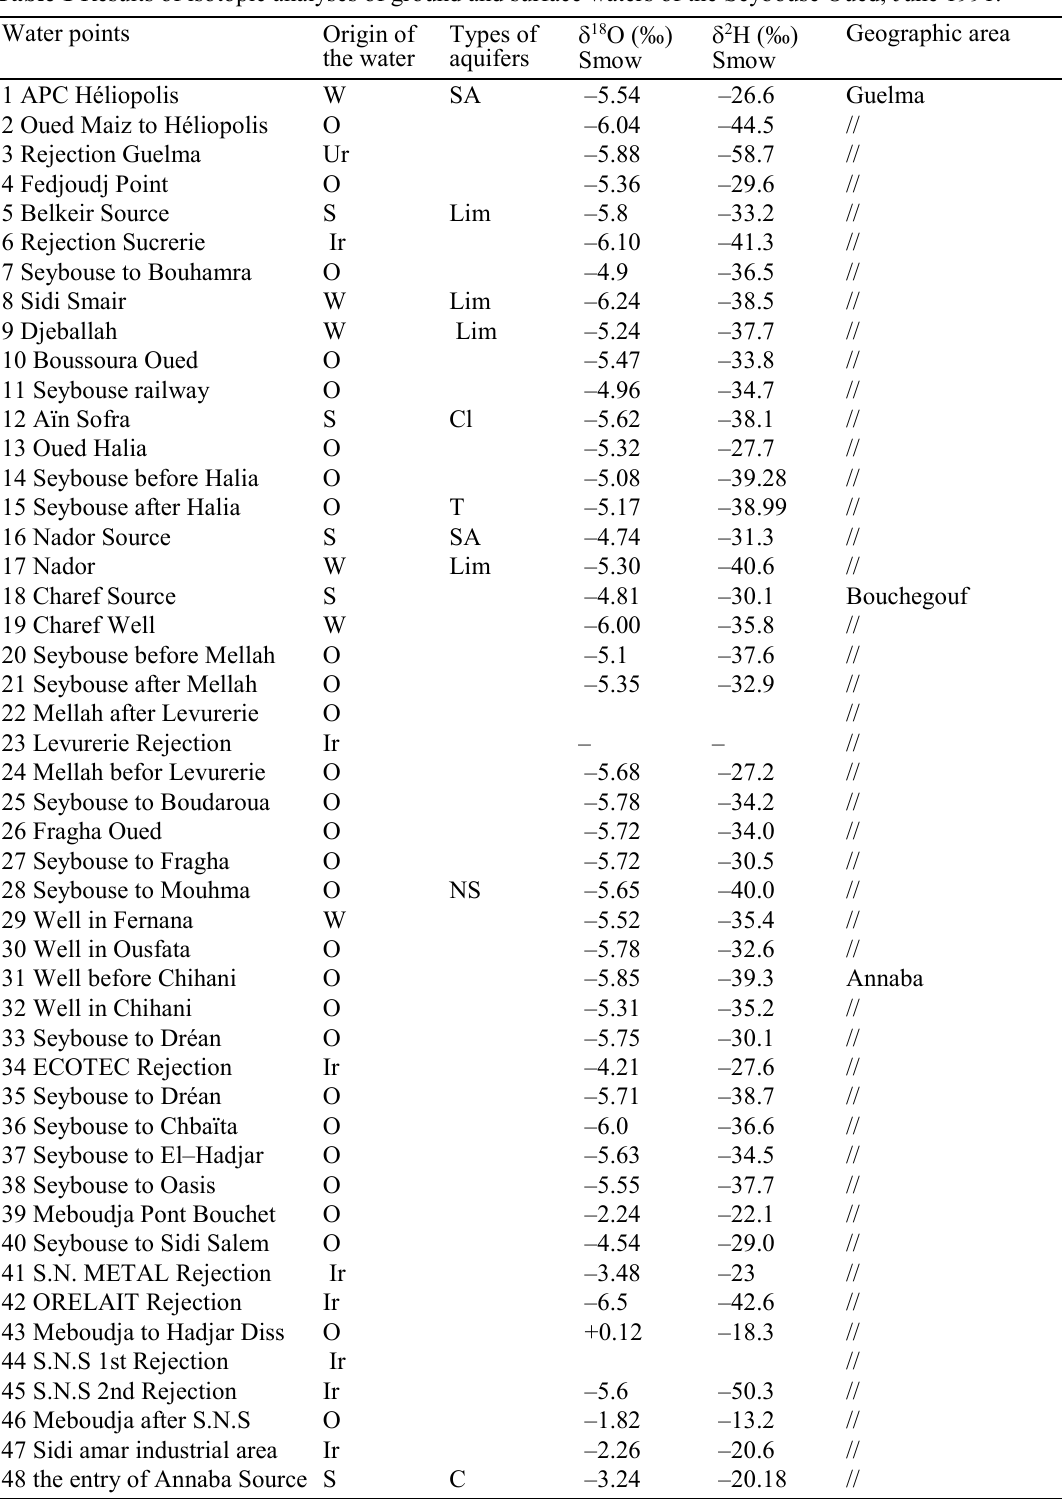
Table 1 Results of isotopic analyses of ground and surface waters of the Seybouse Oued, June